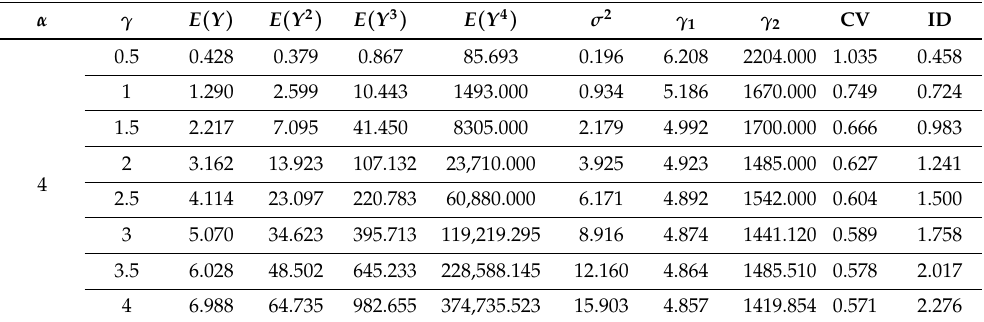
Table 3. Numerical results of E ( Y ) , E ( Y 2 ) , E ( Y 3 ) , E ( Y 4 ) , σ 2 , γ 1 , γ 2 , CV , and ID for the HL-INH distribution at λ =